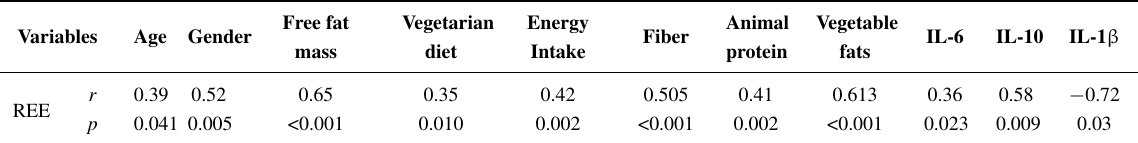
Table 3. Univariate analysis, Pearson correlation variables correlated with resting energy expenditure (REE).